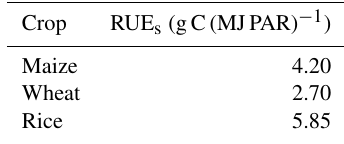
Table 2. Base radiation use efficiency (RUE s ) for each